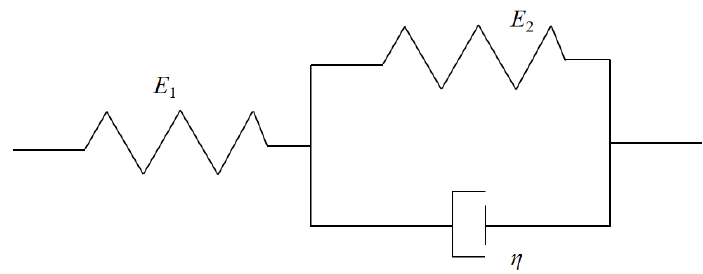
Figure 1. The relationship between subscription 1 and 2 .